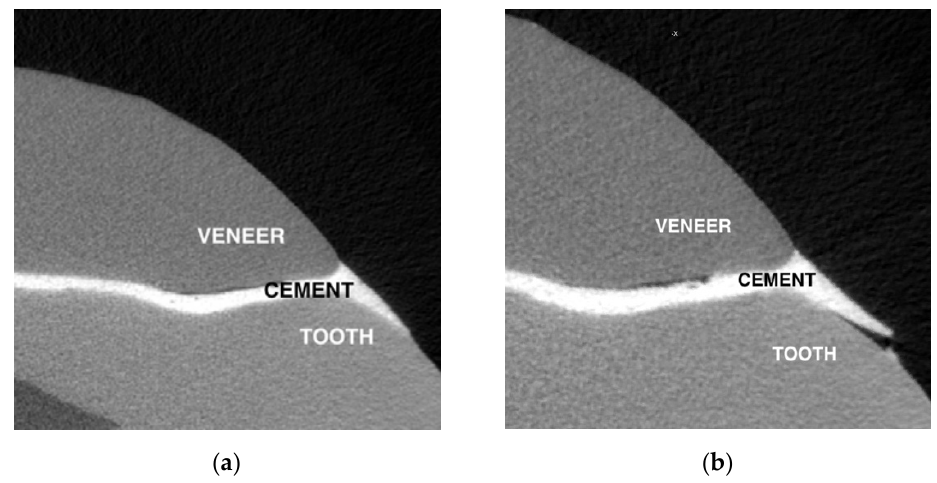
Figure 9. Sample number 13 before and after thermocycling: ( a ) small defects and cement layer overfill before thermocycling; ( b ) after thermocycling, defects adjacent to enamel and veneer are visible.